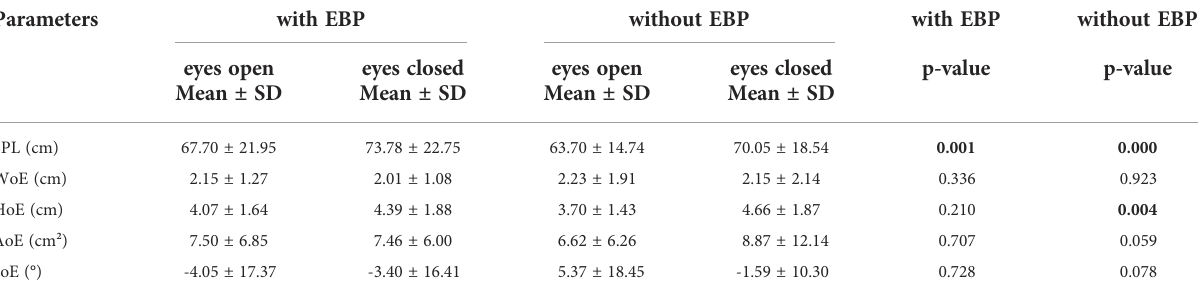
TABLE 7 Comparison of the results of the posturographic tests with eyes open and closed during self-standing in a free standing position during the tests with and without EBP (N = 52). Parameters